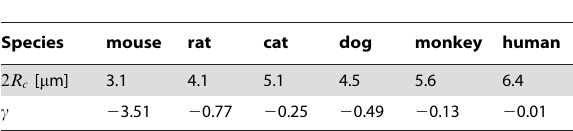
Table 2. Exponent c as a function of capillary